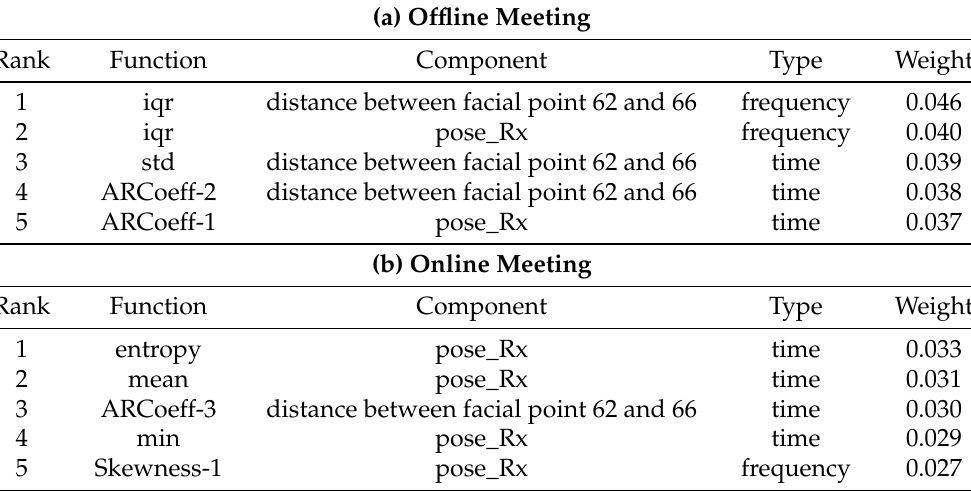
Figure 9. Confusion Matrix of nodding and other . Used facial points and head rotation data as features. Down sampling was applied. Only online meeting datasets were used. Dataset was split into two patterns: ( a ) 10-fold random split and ( b ) Leave-One-Participant-Out. Random forest was used as the machine learning algorithm. Table 4. Feature Importance of Micro-Behaviour